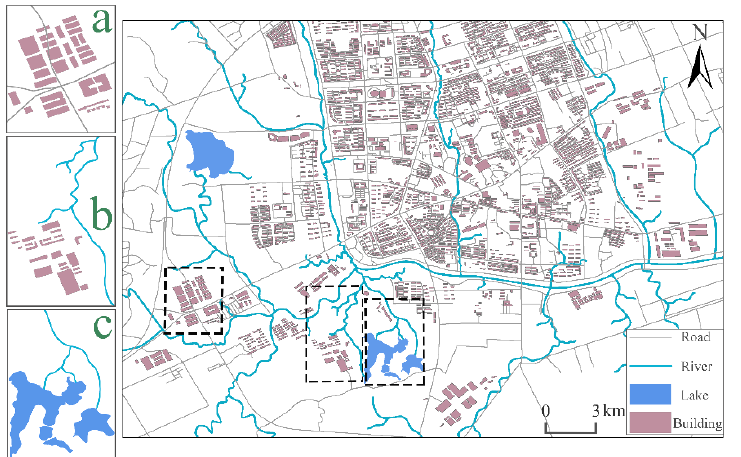
Figure 1. Map and the extracted micro scenes ( a ) (block composed of roads and buildings), ( b ) (an urban waterfront composed of buildings and rivers), and ( c ) (a river system formed by rivers and lakes).